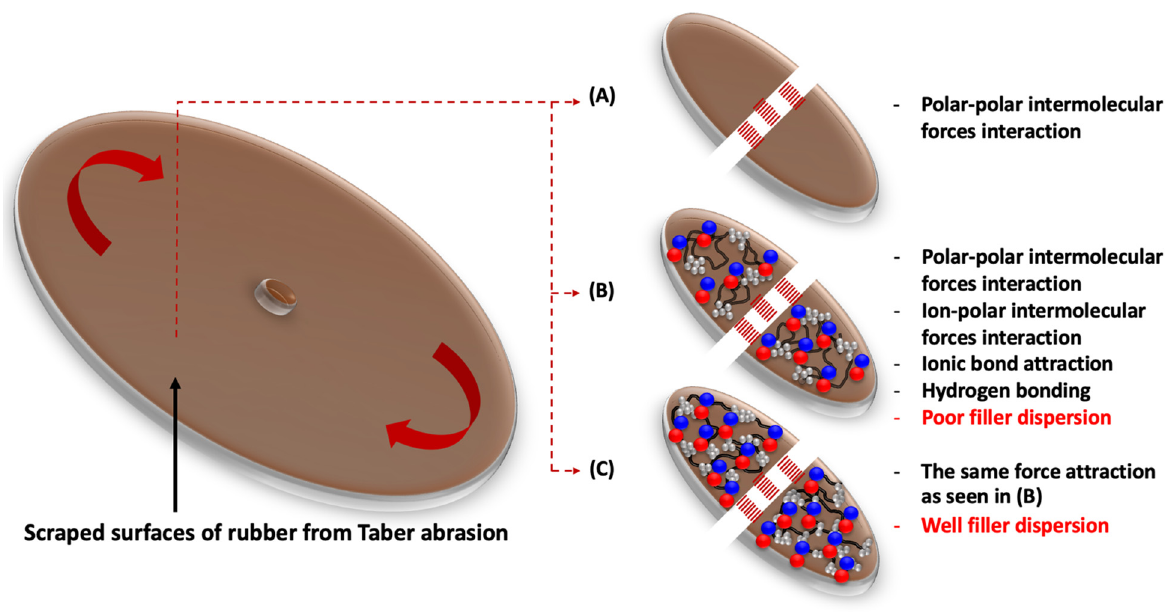
Figure 8. Proposed model of each composite after Taber resistance testing of BIIR/ENR ( A ), M- BIIR/ENR-HF ( B ) and M-BIIR/ENR-HF Si ( C ).